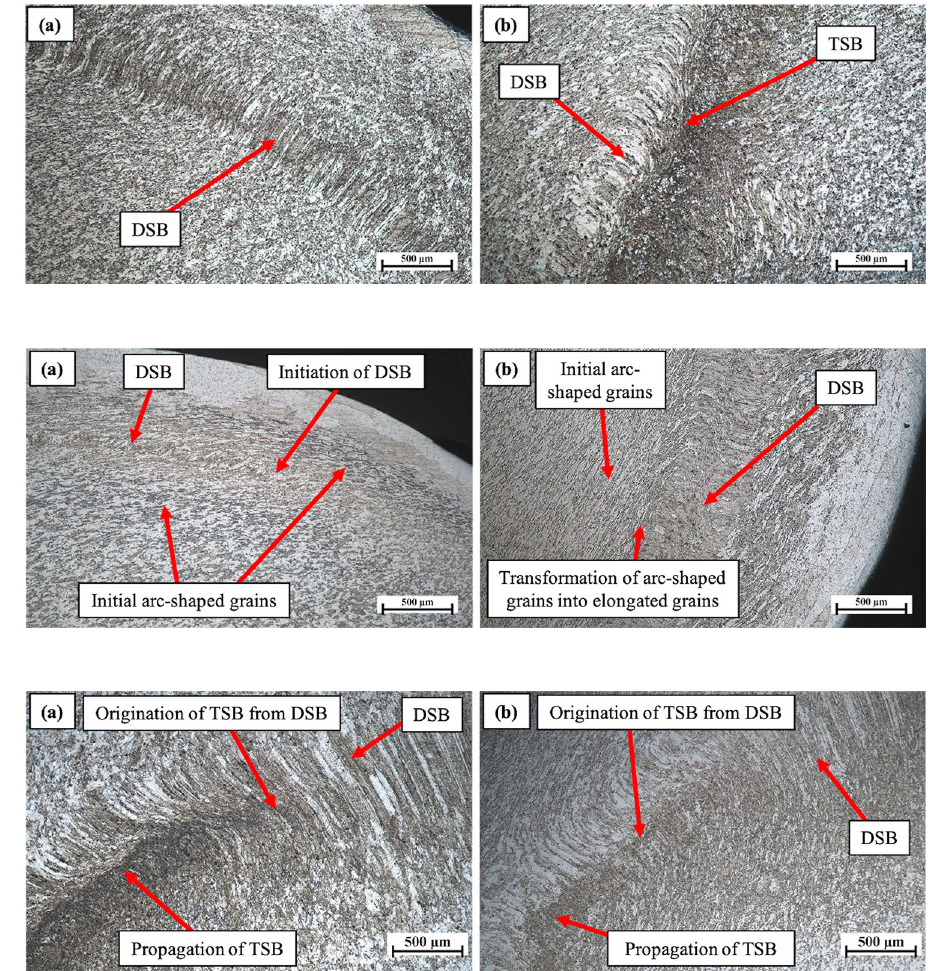
Fig. 8 OM images showing ( a ) distorted elongated grains characterizing DSB in speci- men deformed with 4700 s −1 at 200 °C, and ( b ) recrystallized UFGs characterizing TSB, along with the presence of DSB, in specimen deformed with 4300 s −1 at 300 °C